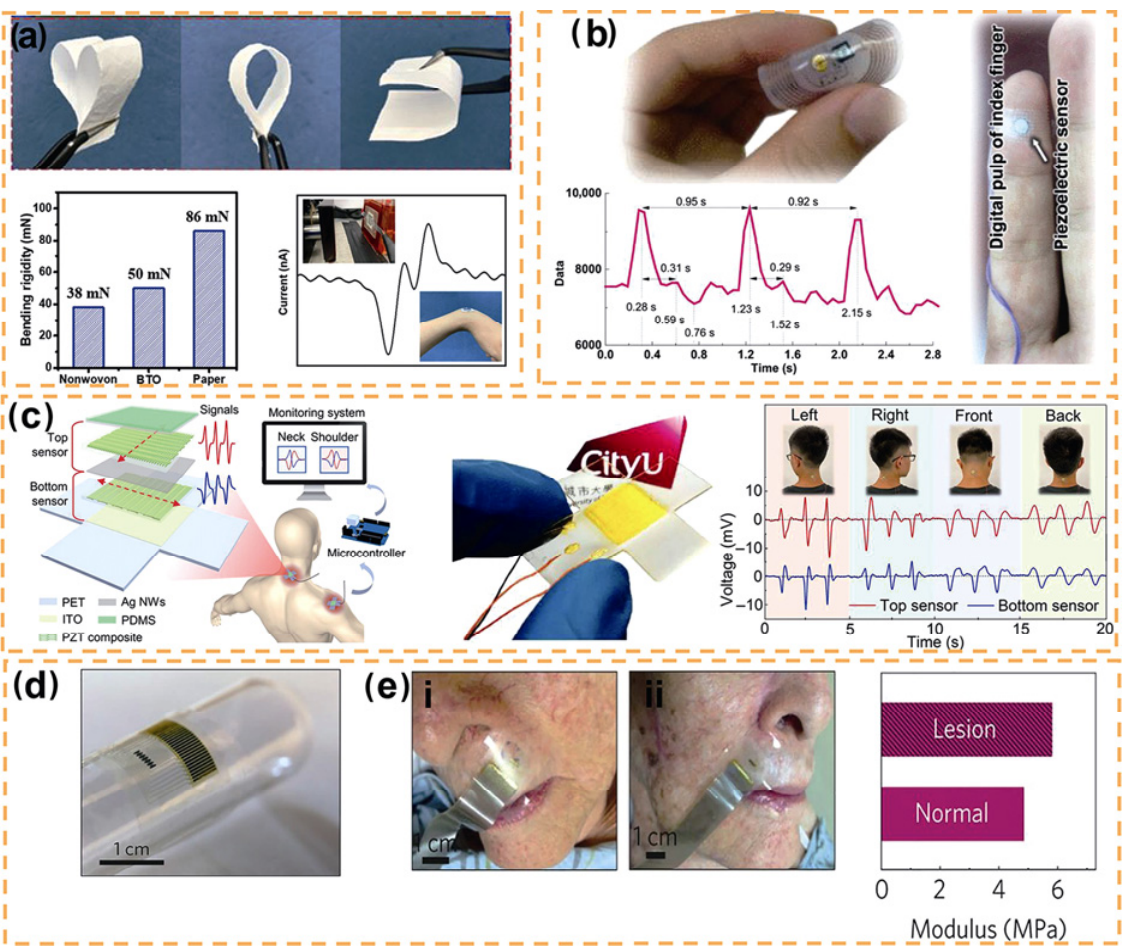
Fig. 9 Wearable application. (a) Bending rigidity and typical pulse signal of flexible BTO nanofiber films. (b) Photograph of wireless arterial pulse sensing system and acquired pulse waveforms of index finger. (c) Structure of highly anisotropic piezoelectric network composite (HAPNC) sensor and piezoelectric signals produced from neck motions. (d) Photograph of conformal piezoelectric systems on a thin silicone substrate. (e) Photographs of skin near nose with (i) lesion and (ii) normal conditions and corresponding modulus values at an actuation voltage and frequency of 5 V and 1 kHz, respectively. Reproduced with permission from Ref. [126] for (a), © WILEY-VCH Verlag GmbH & Co. KGaA, Weinheim 2019; Ref. [15] for